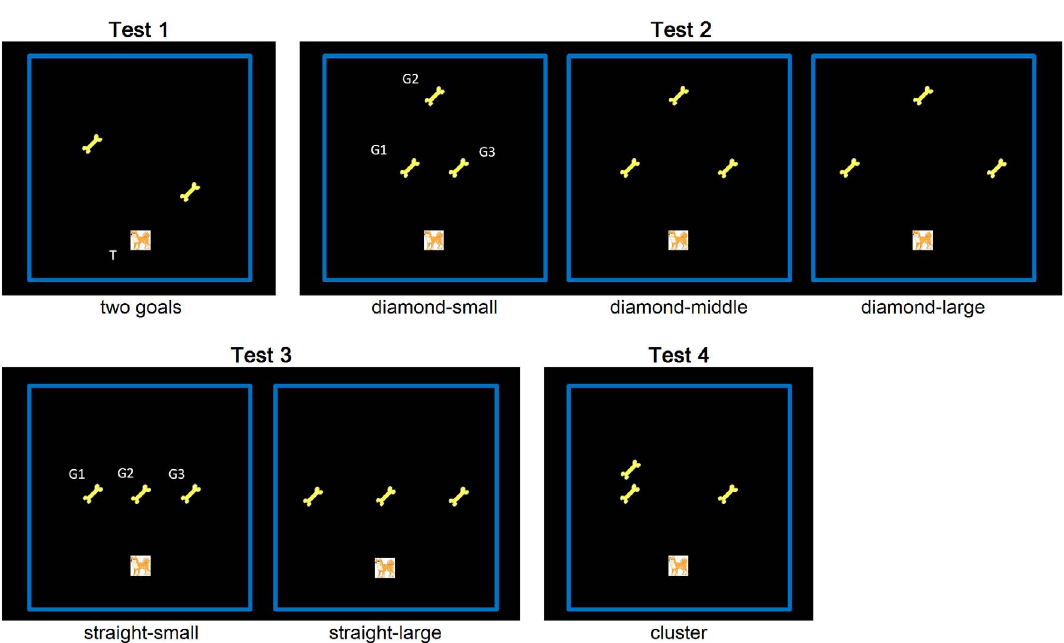
Fig. 2. TSP versions used during each test phase (Tests 1–4). The picture of the dog at the bottom of each task (T) represents the starting location of the target, and the pictures of the bone (G1, G2, [and G3]) represent the goals. Variations in the target’s starting location are available by rotating each figure by 90, 180, or 270